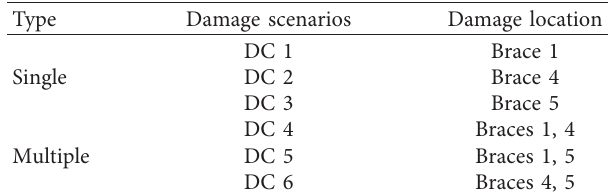
Figure 9: The relationship between the first three-order AR coefficients and damage severity: (a) first-order AR coefficients; (b) second- order AR coefficients; (c) third-order AR coefficients. Table 2: Numerical damage scenarios of the ASCE steel-braced frame